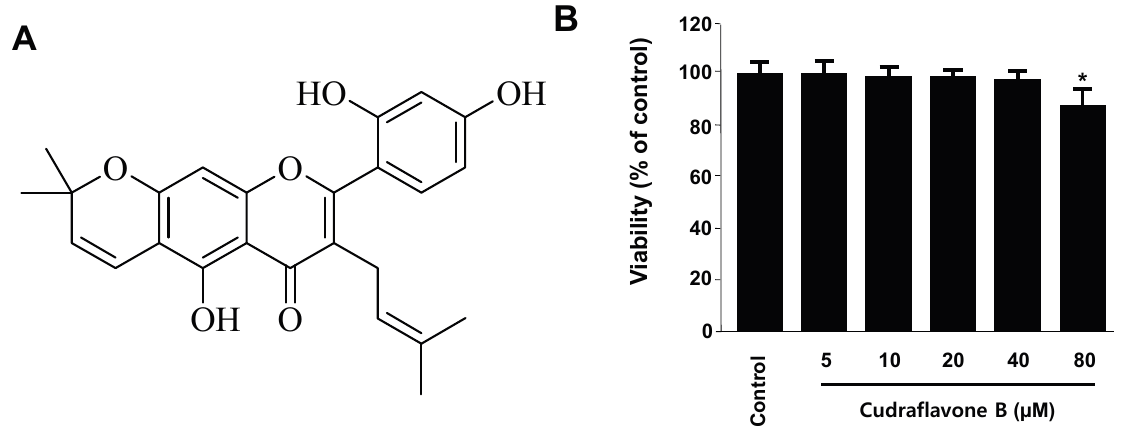
Figure 1. The structure of cudraflavone B ( A ) and effects of cudraflavone B on cell viability ( B ) in HT22 cells. HT22 cells were incubated for 48 h with various concentrations of cudraflavone B (5–80 μ M). Data are presented as mean ± SD values of three independent experiments. * p < 0.05 vs.